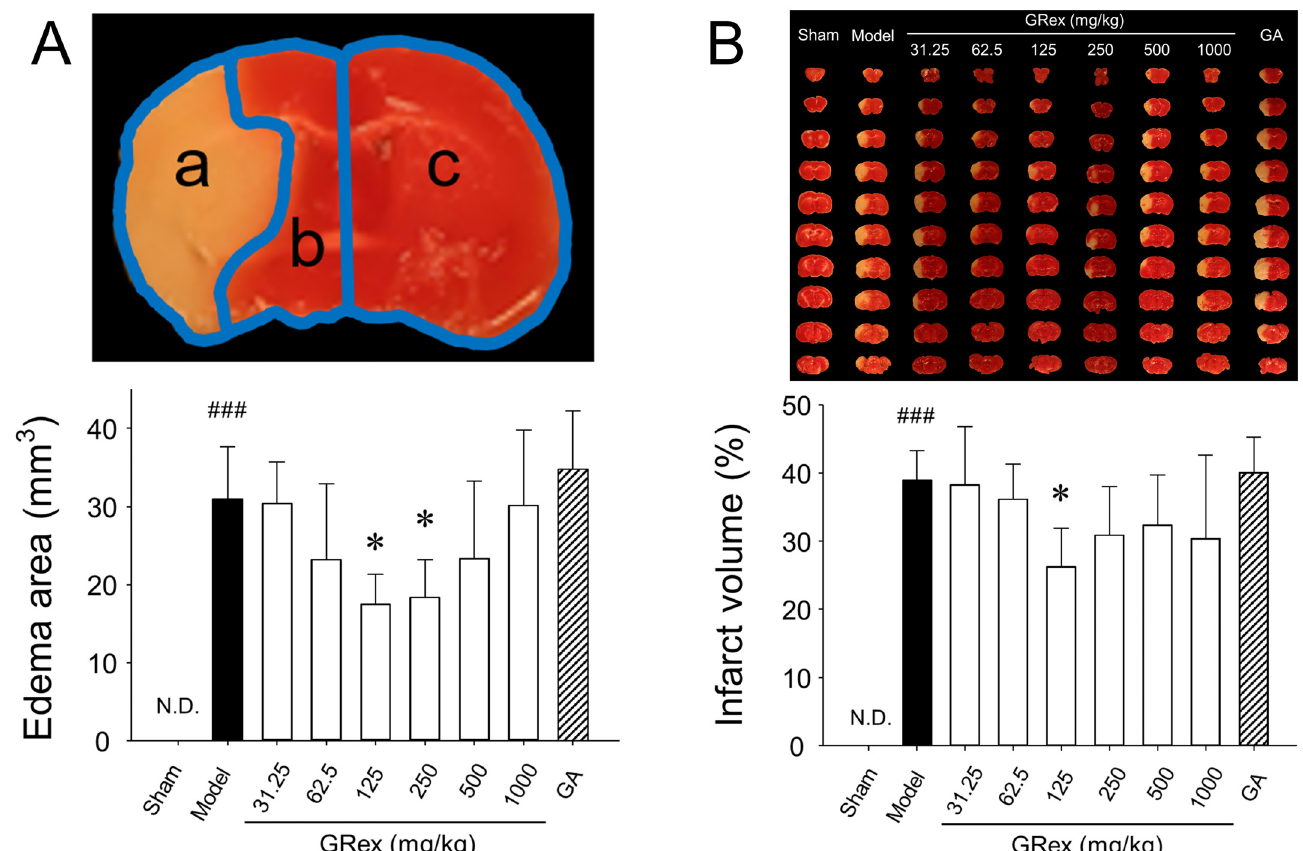
Figure 3. Measurements of edema area and infarct volume: ( A ) quantitative analysis of the edema area, determined as (a [ipsilateral infarct volume] + b [ipsilateral non-infarct volume] — c ([contralateral volume]) using 2,3,5-triphenyltetrazolium chloride (TTC)-stained brain slice; ( B ), representative photographs of TTC-stained brain slices (1 mm) showing the infarct area 24 h after middle cerebral artery occlusion (MCAO) (upper column) and quantitative analysis of the total infarct volume (lower column). GA, glycyrrhizic acid. All data are expressed as mean ± SD ( n = 5). ### p < 0.001 compared to sham group and * p < 0.05 compared to MCAO model group.